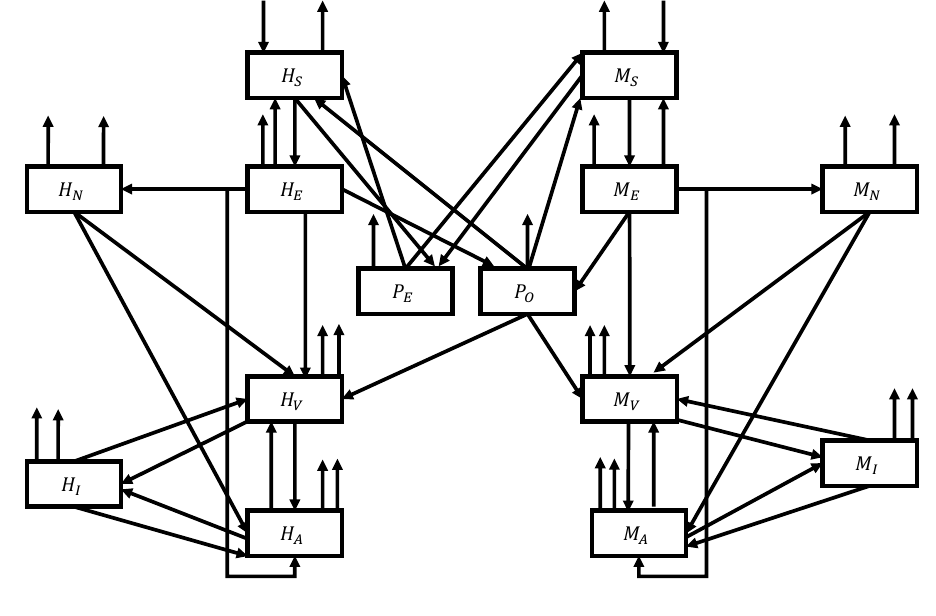
Fig. 1: Diagram of model (12). Table I: Description and numerical values of parameters of the model